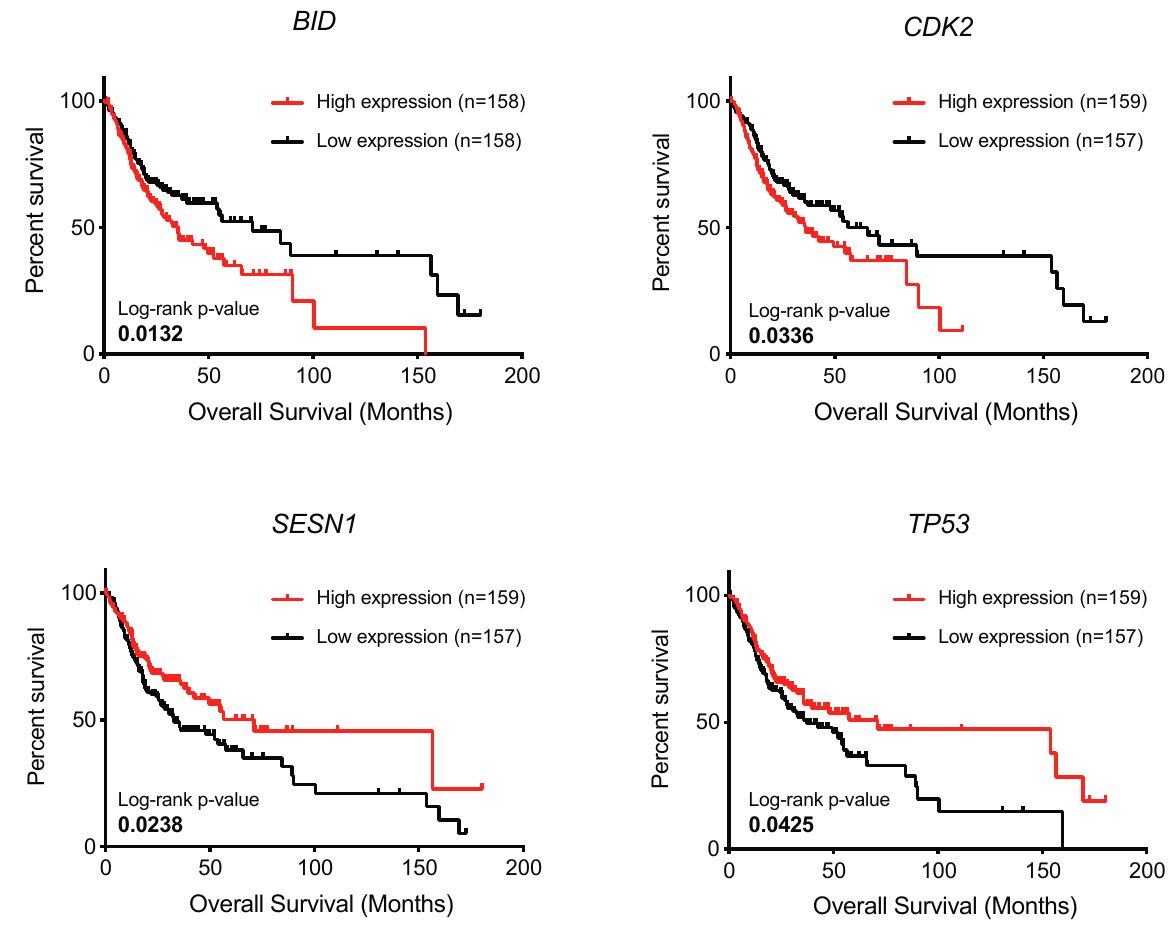
Figure 4. Impact of DDR gene expression on overall survival of OSCC patients. Kaplan–Meier curves depicting the overall survival associated with ( a ) BID , CDK2 , and ( b ) SESN1 and TP53 expression of patients affected by OSCC. Significant Log-rank p -values are reported in the figure.